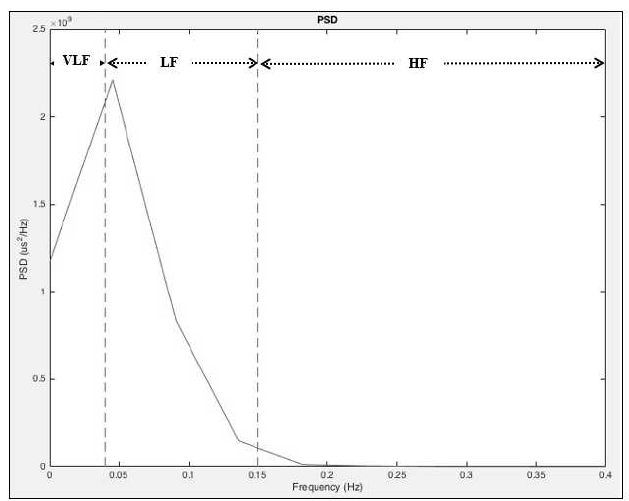
Figure 3. Example of Power Spectrum Density (PSD) for first 30-seconds epoch from patient-1 with